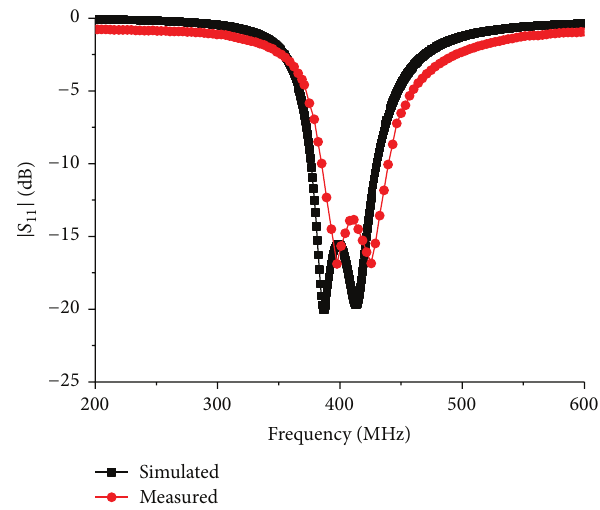
Figure 9: Comparison of the simulated and measured |𝑆 11 | of the proposed antenna.